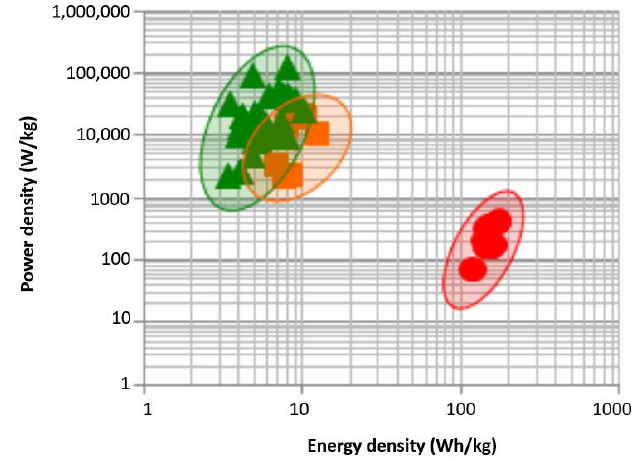
Figure 3. The Ragone plot for different ESSs [24].